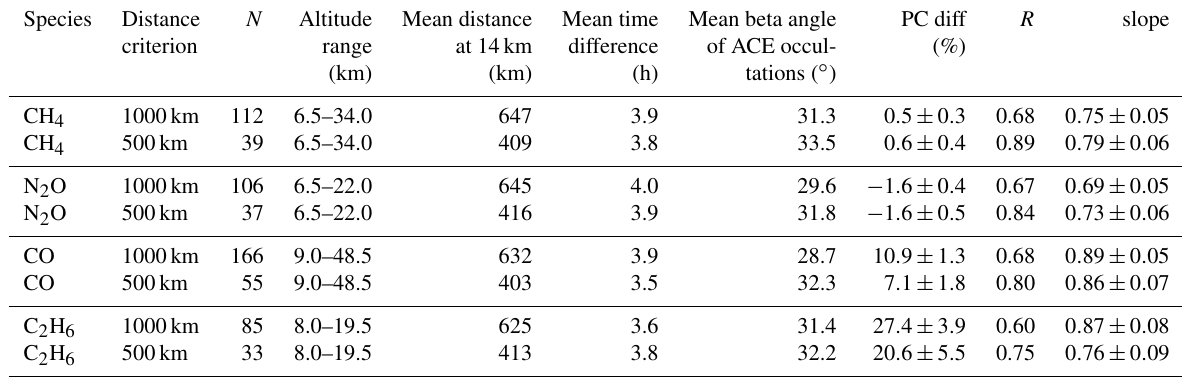
Table 7. Same as Table 6, but for the comparison of ACE-FTS v3.5 and the Bruker 125HR partial columns (2007–2013). Species Distance N Altitude Mean distance Mean time Mean beta angle PC diff R slope criterion range at 14km difference of ACE occul- (%) (km) (km) (h) tations ( ◦ ) CH 4 1000km